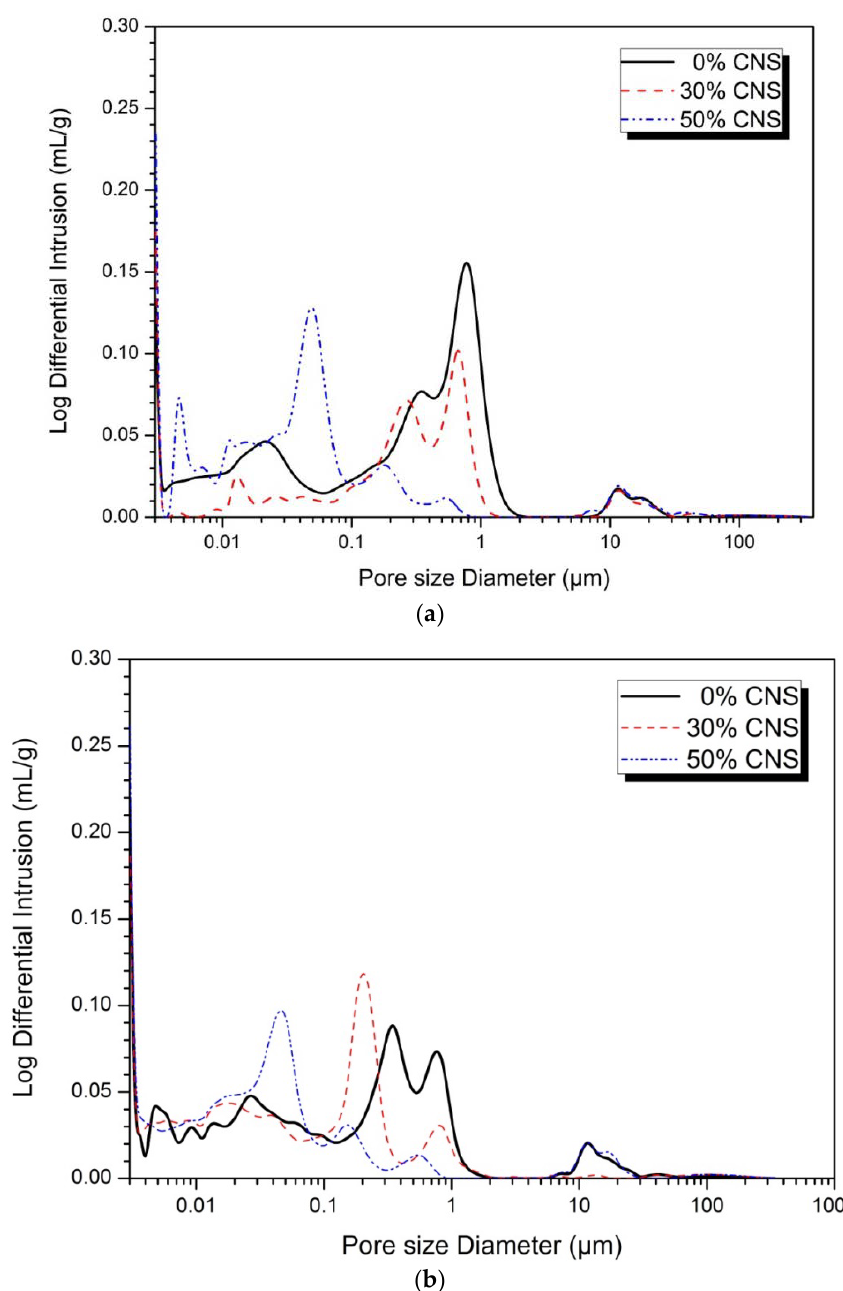
Figure 6. MIP results, ( a ) 1-day, ( b ) 28-day.